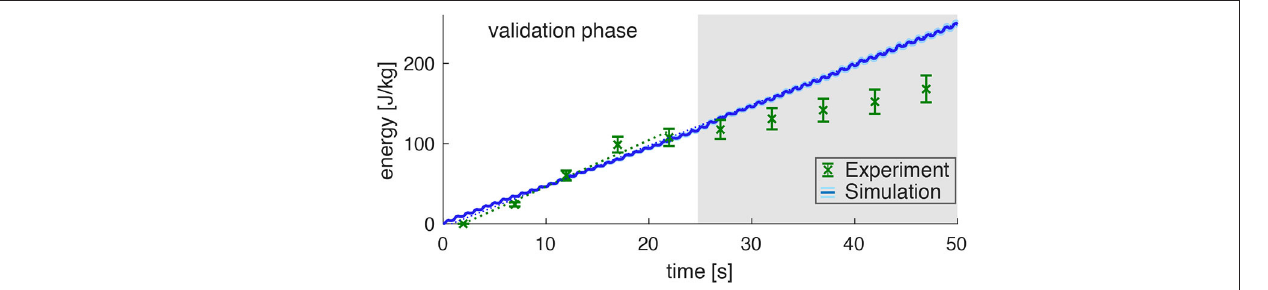
FIGURE 5 | Prediction of the energy consumption by the model (mean: blue line, standard deviation: very small light-blue shade around the blue line) compared to the measured energy consumption in the experiments (derived from the PCr decay; green data points) for dynamic plantarflexion. The model predicts the energy rate ( ˙ E sim = 5.081 ± 0.064Jkg − 1 s − 1 , linear fit, dotted blue line) as the sum of activation-maintenance heat, shortening-lengthening heat, and mechanical work performed by the muscle fibers: ˙ E = ˙ h AM + ˙ h SL + ˙ w CE . The experimental data shows a similar energy rate ( ˙ E exp = 5.8 ± 1.8Jkg − 1 s − 1 , linear fit, dotted green line) during